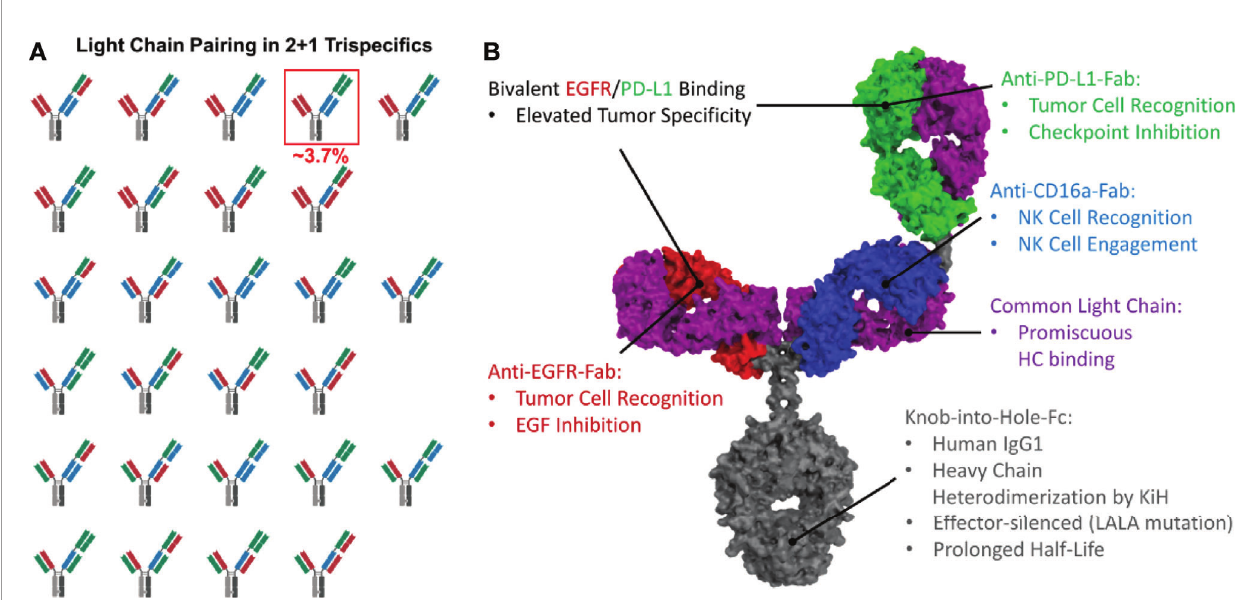
FIGURE 1 | Possible light chain pairing combinations and structural model of trispeci fi c antibodies. (A) In 2 + 1 trispeci fi cs, 27 different light chain pairing combinations are possible, resulting in only ~3.7% correctly paired antibodies. The correctly paired variant is highlighted. (B) Structural model of a 2 + 1 trispeci fi c antibody exhibiting common light chains to circumvent light chain mispairing. Intended functionalities are